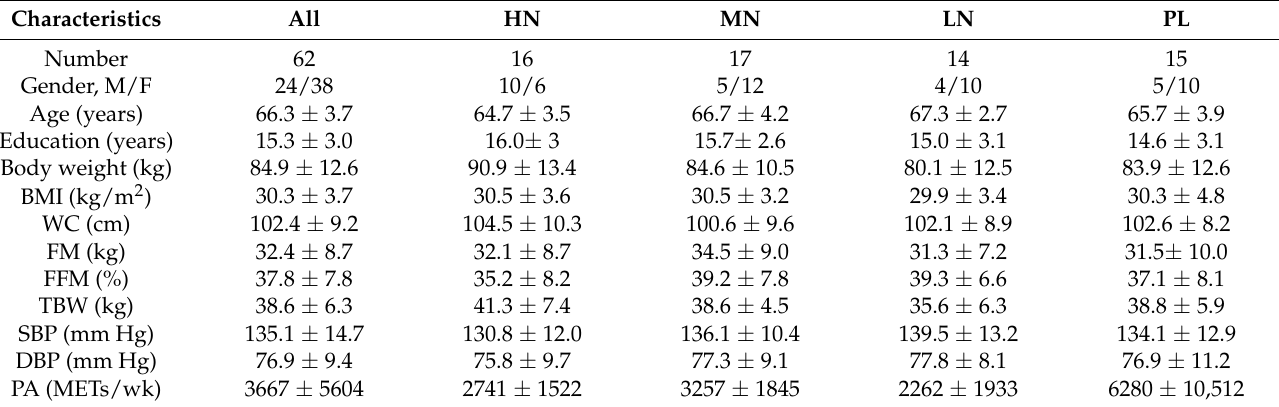
Table 1. Baseline characteristics of the study participants